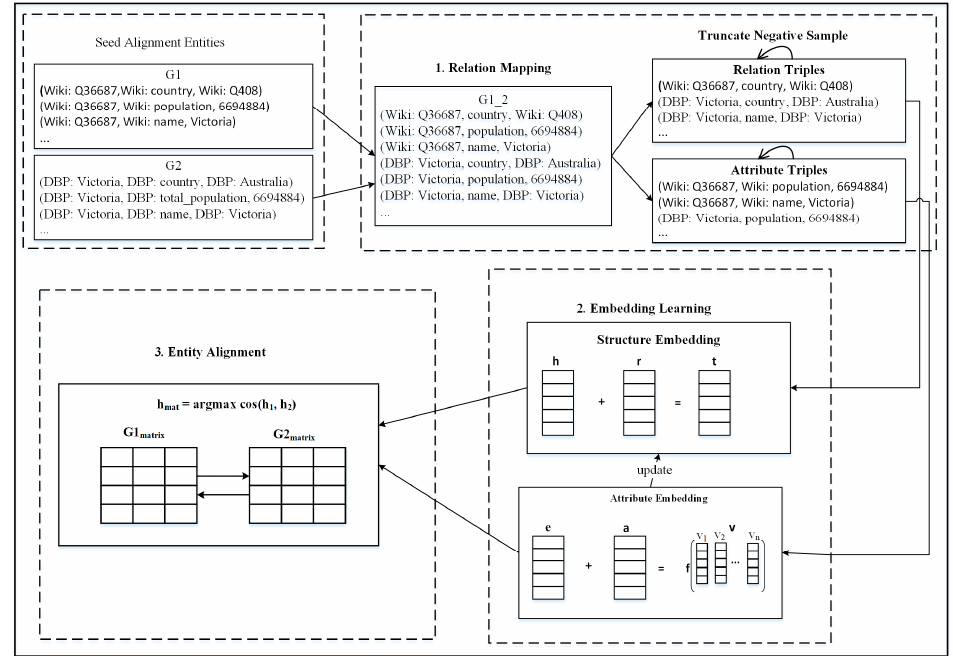
Figure 2. Entity alignment